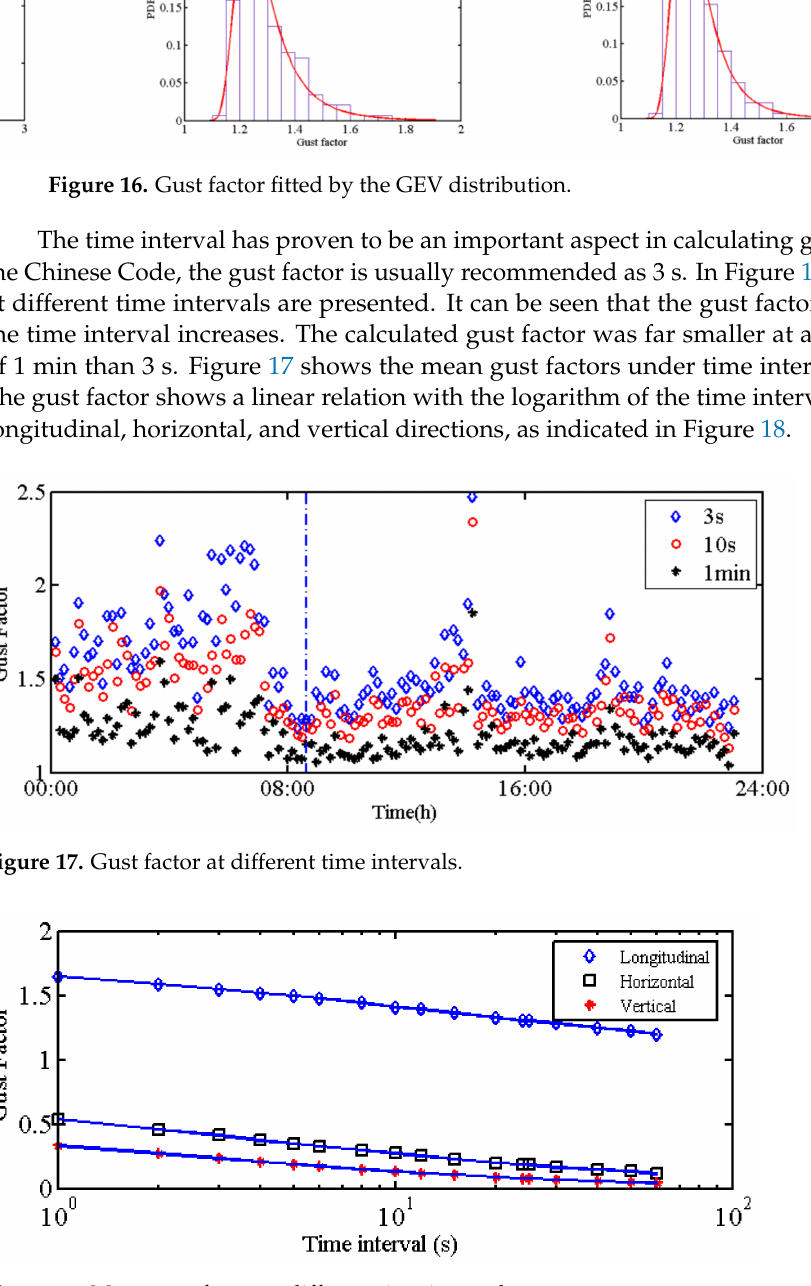
Figure 18. Mean gust factor at different time